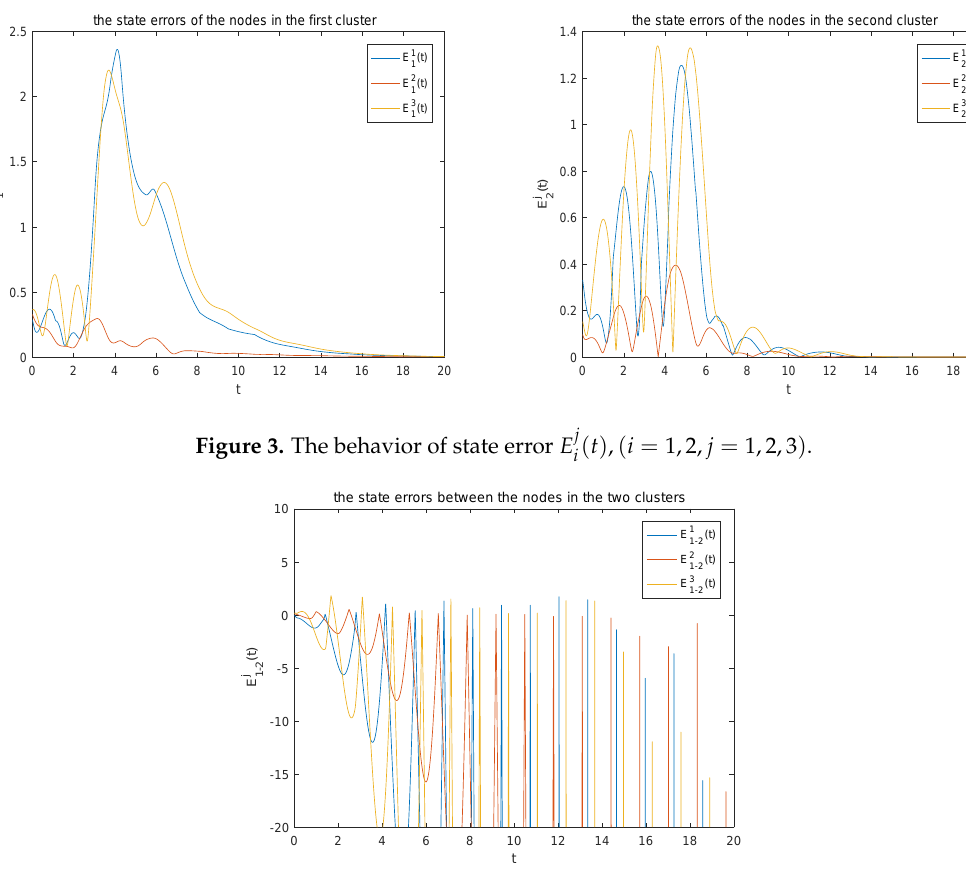
Figure 4. The state errors between the nodes in the two